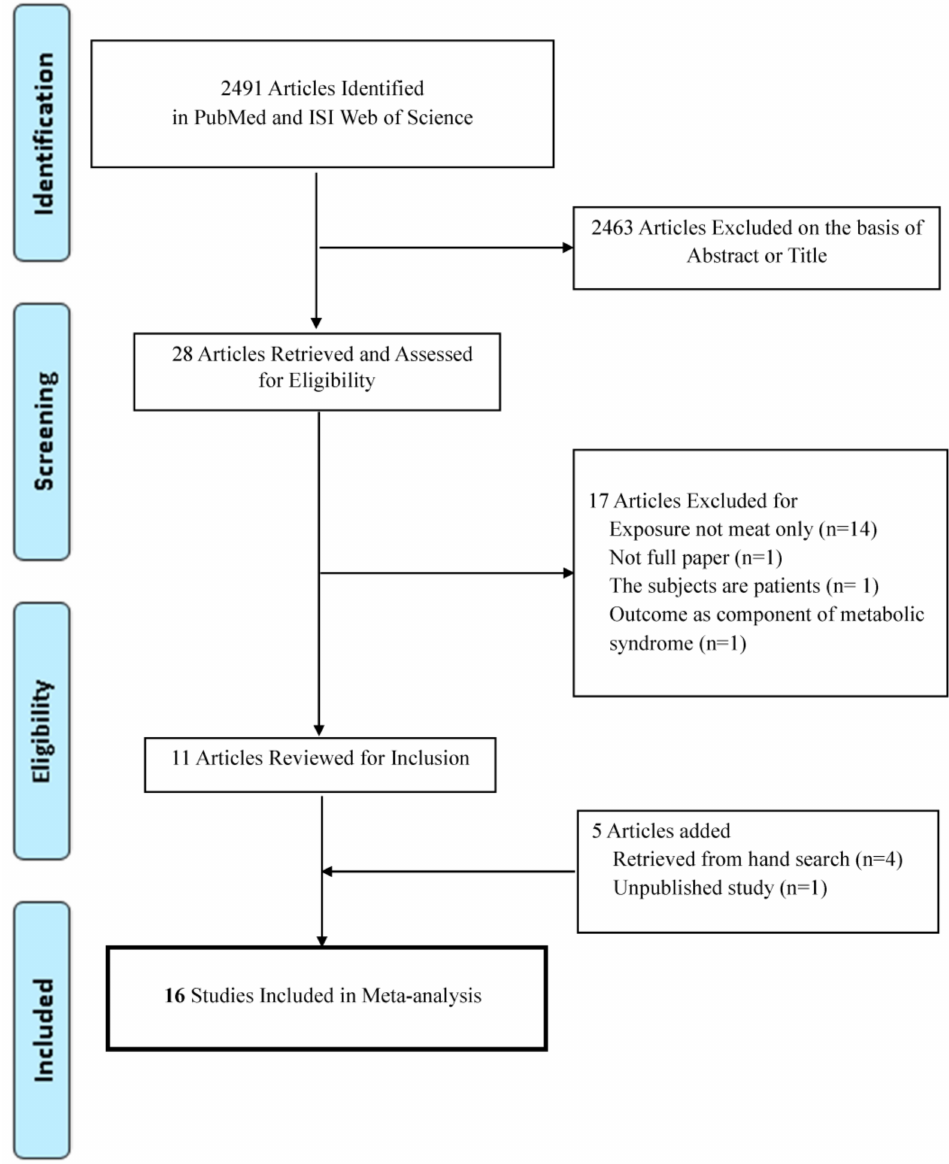
Figure 1. Flow chart of the selection of studies included in the